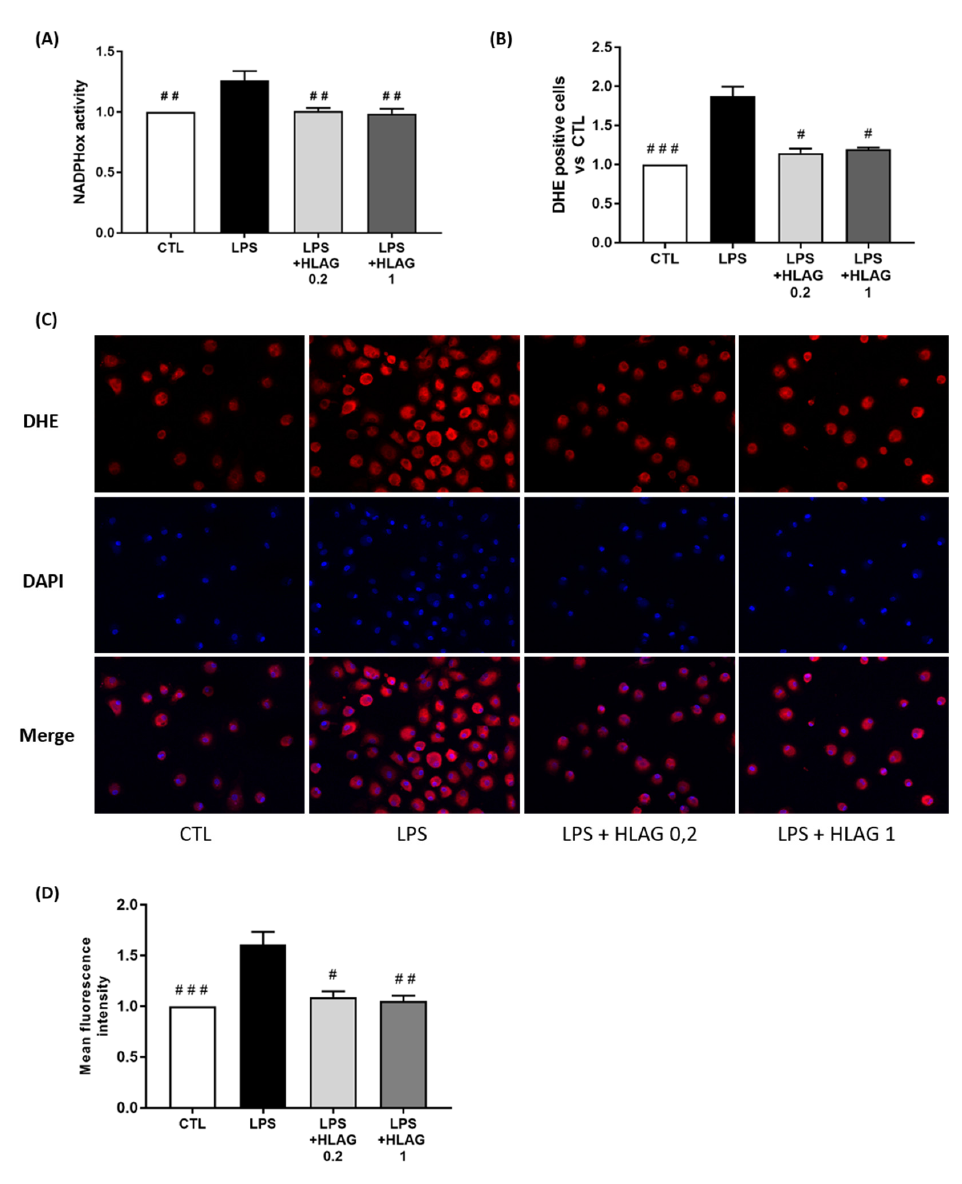
Figure 7. Effect of recombinant HLA-G on ROS production in macrophages. Macrophages were stimulated with LPS plus recombinant HLA-G at 0.2 or 1 µg/mL. ( A ) NADPHox activity measured by luminometric analysis and related to the protein levels. Relative values versus CTL are represented as mean ± SEM, n = 8, ## p < 0.01 versus LPS. ( B ) Proportions of DHE-positive cells represented as fold induction versus CTL (mean ± SEM), n = 6, # p < 0.05 and ### p < 0.001 versus LPS. ( C ) Fluorescence images of DHE (red) and DAPI (blue) staining, taken with an epifluorescence microscope at ×200 magnification in randomly selected fields, representative of five pictures taken for each condition, n = 8. ( D ) Mean fluorescent intensity of DHE staining represented as fold induction versus CTL (mean ± SEM), n = 8, # p < 0.05, ## p < 0.01 and ### p < 0.001 versus LPS.